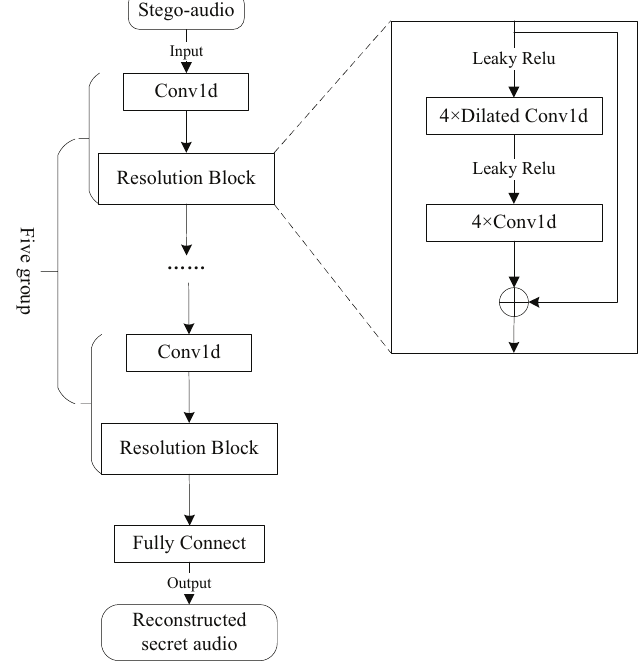
Figure 3. The extractor